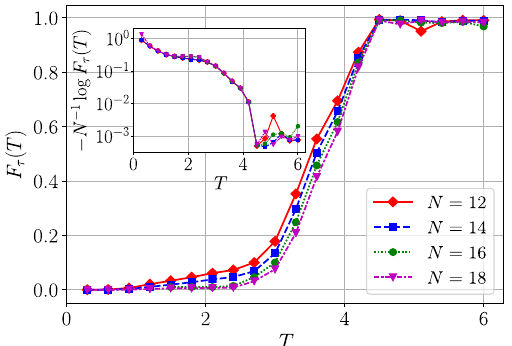
FIG. 18. Spin- 1 = 2 Ising model: many-body fidelity maximi- zation and corresponding quantity (inset, log scale) against protocol duration T for different system sizes N . The QAOA parameters are q ¼ 3 and A ¼ f Z j Z þ Z; X ; Y; X j Y; Y j Z g . The model parameters are the same as in Fig.